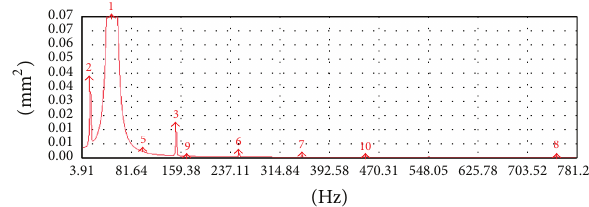
Figure 17: Frequency domain of the wingtip’s dynamic response of an uncontrolled SMA composite wing when the mean wind velocity 𝑉 = 8m/s.